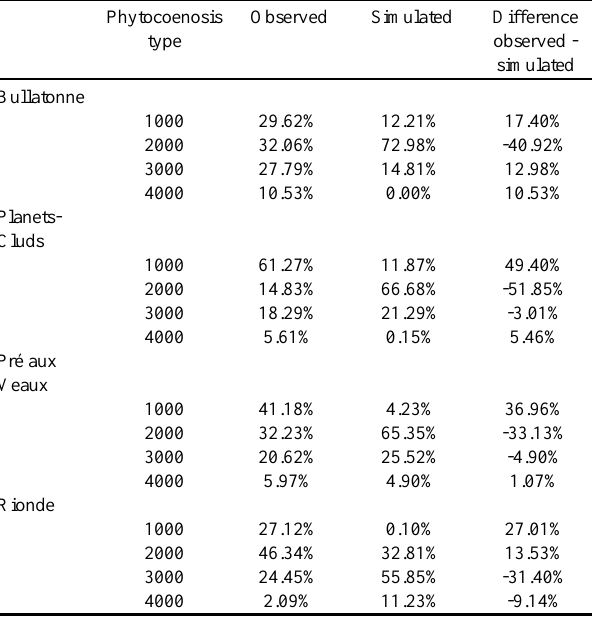
Table 4 . Comparison of simulated and observed proportions of phytocoenosis types describing the composition of the landscape mosaic in each pasture at the end of simulations for retrospective analysis (calendar year